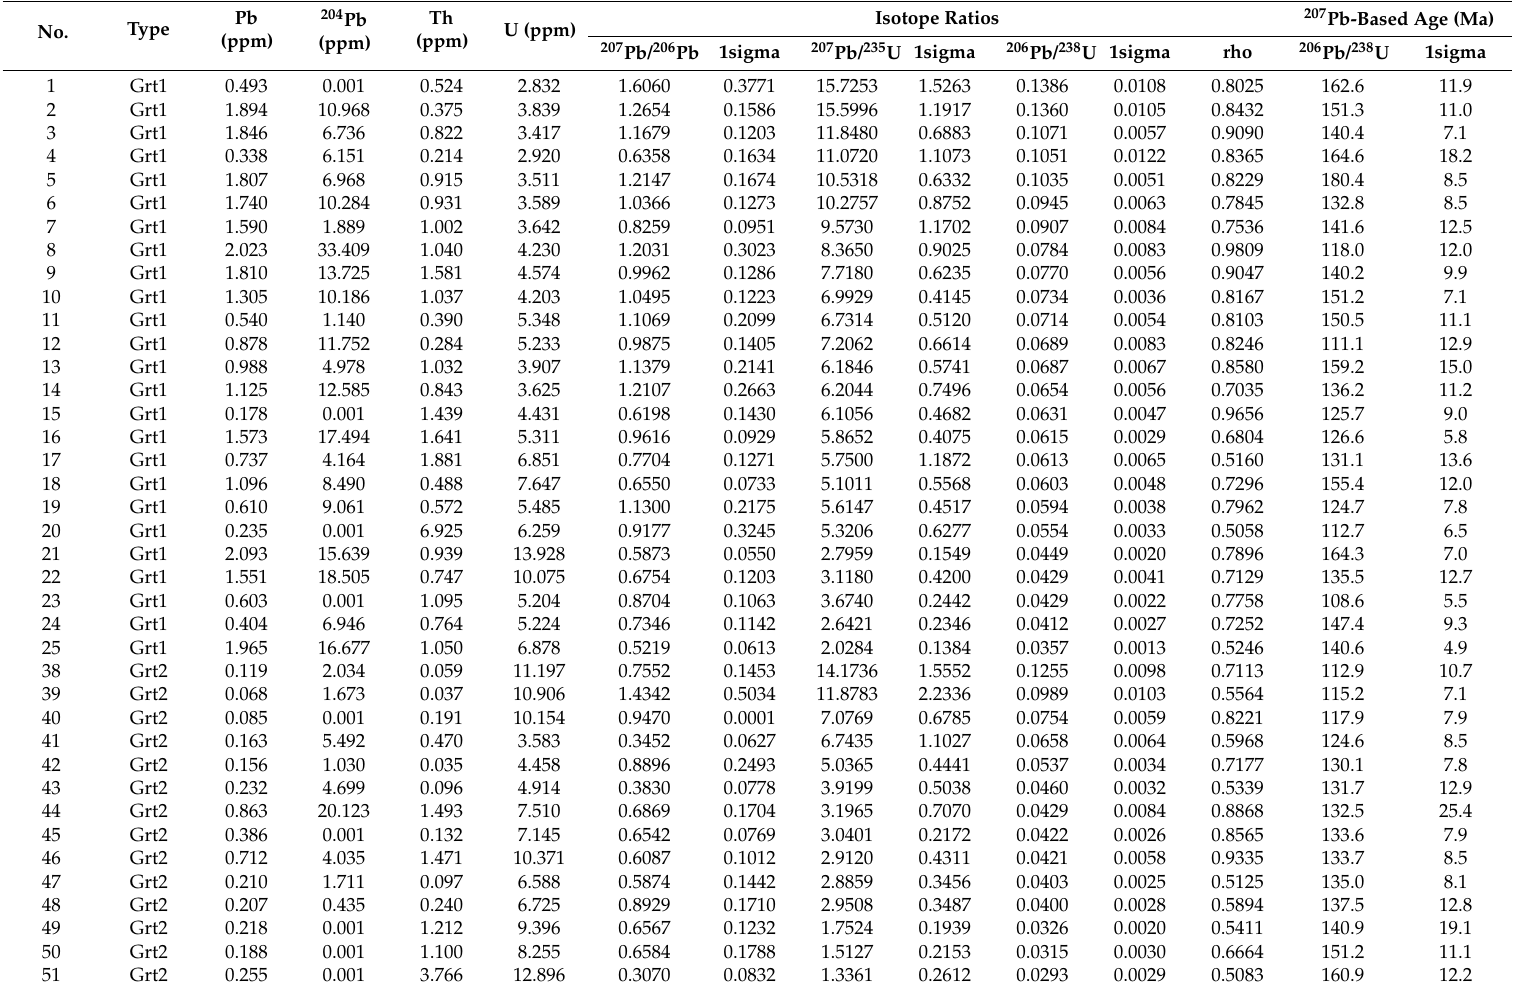
Table 2. LA-ICP-MS U–Pb isotopic data of the Xinqiao